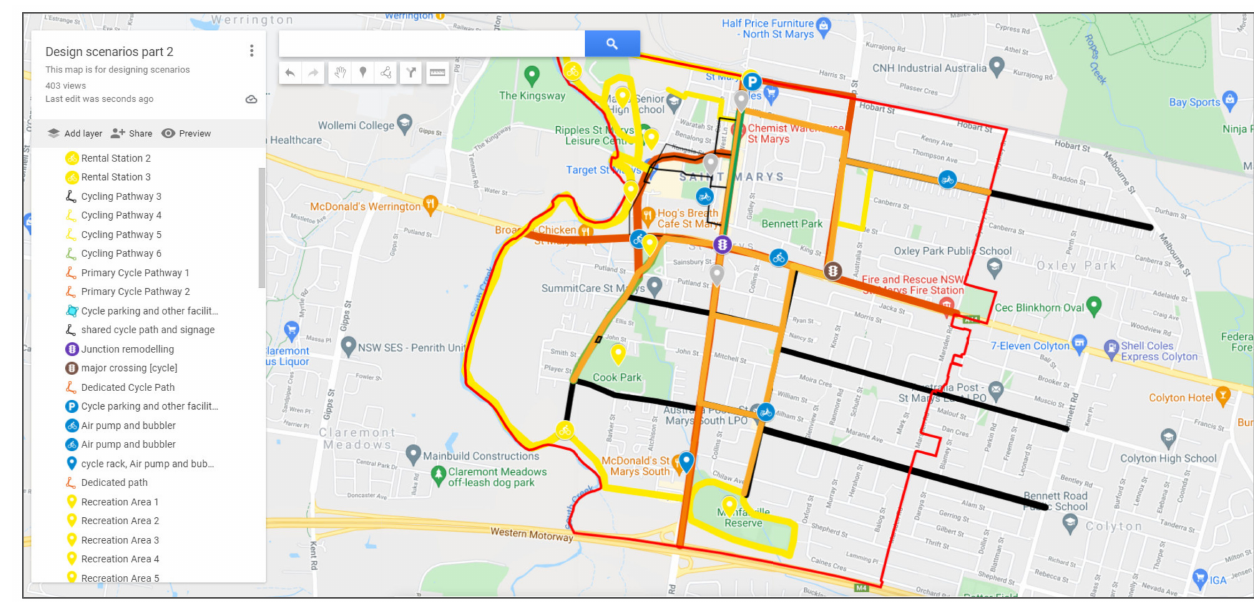
Figure 8. Proposed bicycling network for the case study using Google My Map.